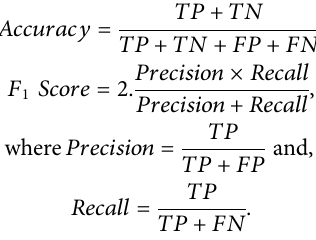
Frontiers in Bioinformatics |